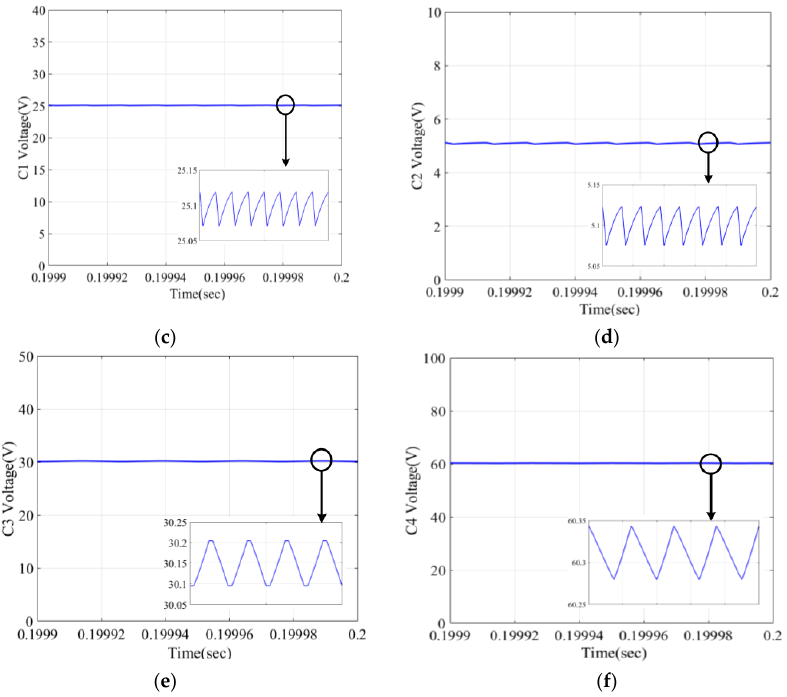
Figure 14. Experimental and simulation result waveforms: ( a ) Input and output voltage (Volt/div = 50 V, Time/div = 10 µs), ( b ) Input and output voltage ( c ) Capacitor C 1 voltage, ( d ) Capacitor C 2 voltage, ( e ) Capacitor C 3 voltage and ( f ) Capacitor C 4 voltage.